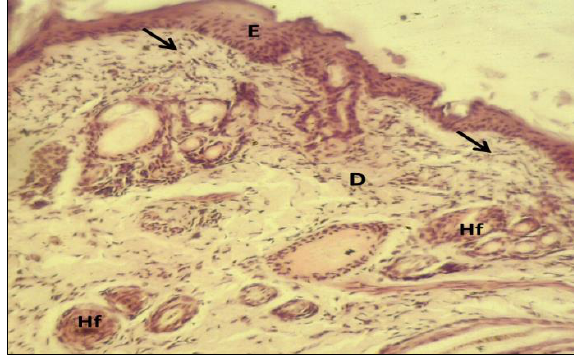
Figure, 18: section of skin (21 days post treatment with pericardial membrane) shows epithelization (E) dermis (D) and hair follicle (Hf) and organized fibroblasts (arrows) H and E, 100x.